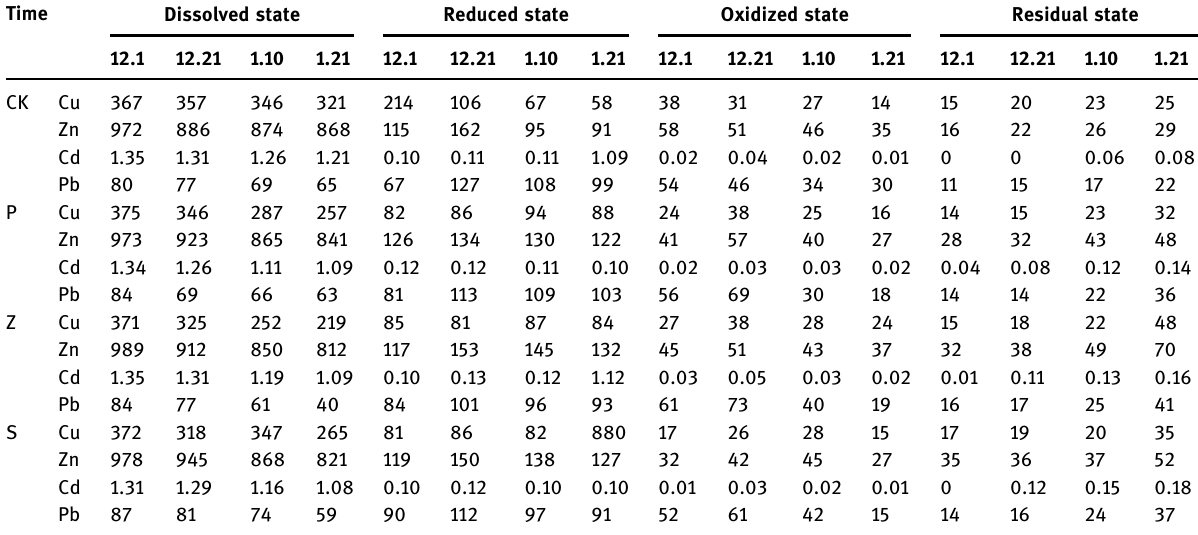
Table 1: Changes in the forms content of four heavy metals treated ( mg/kg ) with di ff erent passivates over